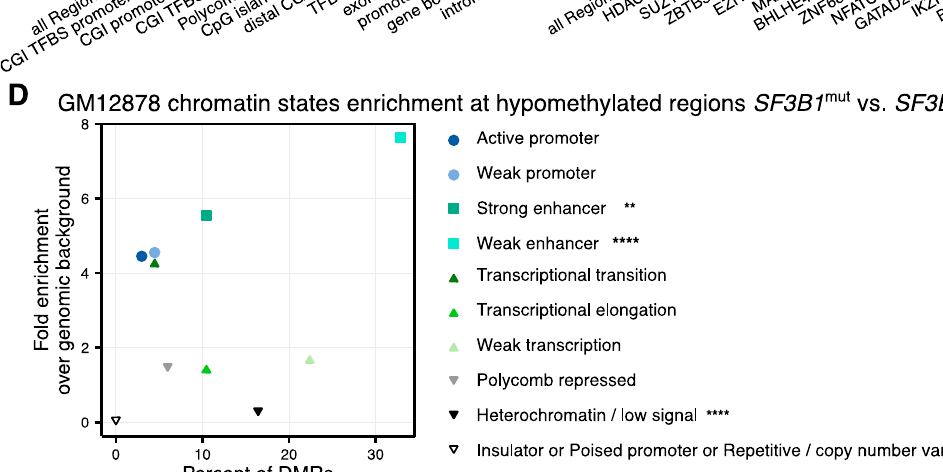
Figure 3. Genomic features of SF3B1 mut vs. SF3B1 WT differentially methylated regions (DMRs) at binding sites. ( A ) Schematic visualization of features used in ( B ) A promoter was defined as a region +/ − 2000 base pairs (kbp) from a transcription start site. CpG islands (CGI) were obtained from [47]. A CGI shore was defined as a 2-kbp region flanking a CGI up—and downstream. A distal CGI is any CGI outside of promoter regions. ( B ) Enrichment analysis of genomic features with differentially methylated regions (DMRs) shown by odds ratio. Enhancer regions are taken from [48]. Tran- scription factor binding sites (TFBS, n = 122) were derived from ENCODE Encyclopedia v.3. PRC2 binding sites were defined as binding sites for EZH2 or SUZ12. ( C ) Enrichment analysis of the TFBS listed in ( B )—only 11 TFBSs with the highest odds ratio are shown. ( D ) Enrichment analysis of the chromatin states as derived from GM12878 cell line [49,50]. Significance is denoted by stars with adjusted p -value (false discovery rate) < 0.05 = “*”; < 0.01 = “**”; < 0.001 = “***”; < 0.0001 = “****”; ≥ 0.05 =